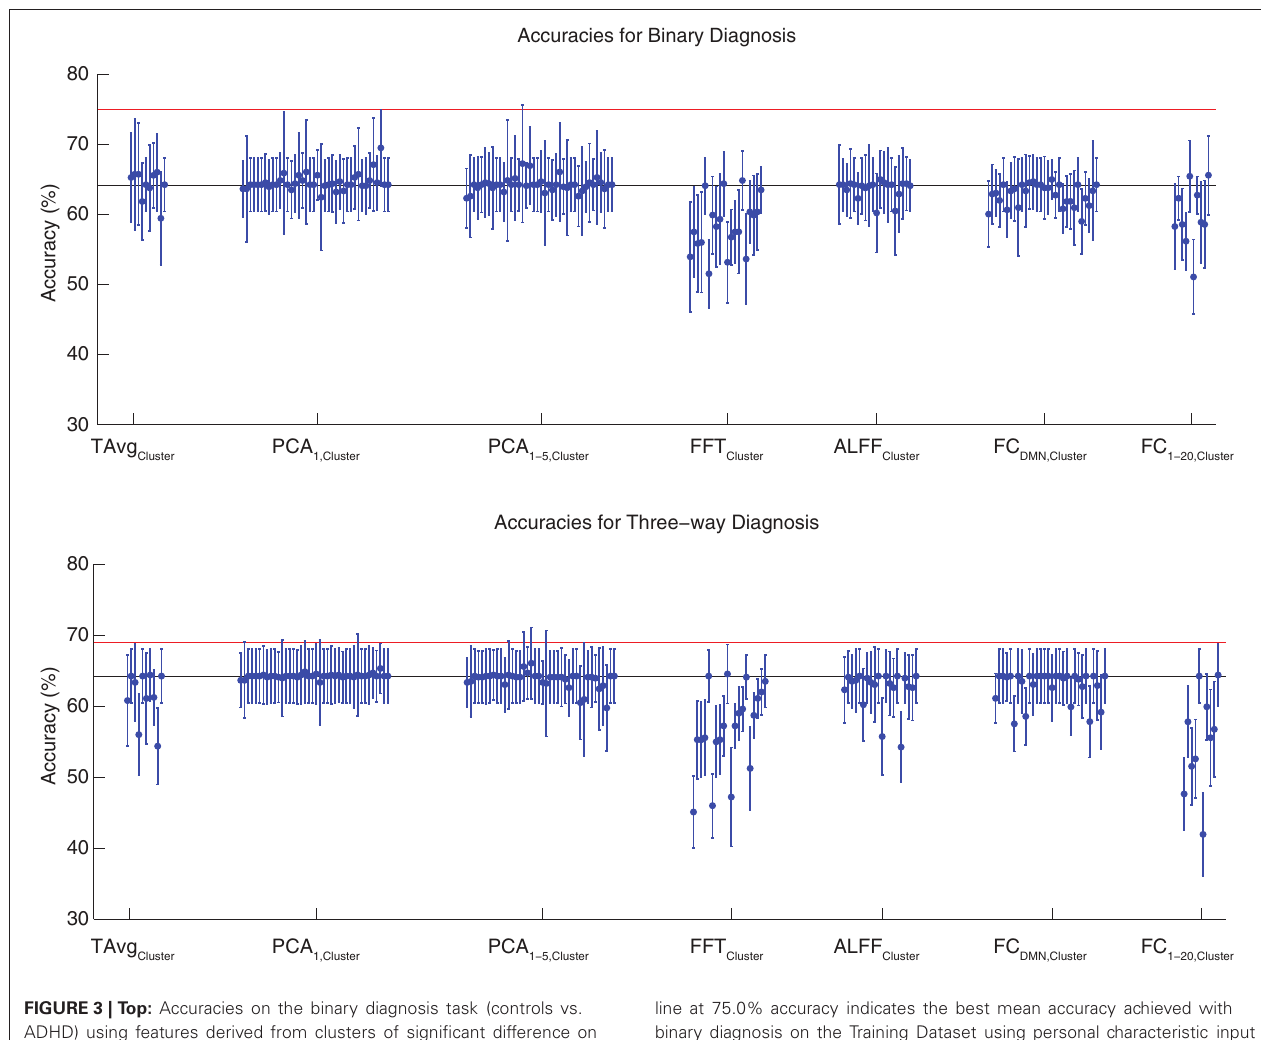
line at 75.0% accuracy indicates the best mean accuracy achieved with binary diagnosis on the Training Dataset using personal characteristic input data (section 3.1). Bottom : Accuracies on the three-way diagnosis task (controls vs. ADHD-C vs. ADHD-I) using same Diagnostic Pipelines as in top panel . The red horizontal line at 69.0% accuracy indicates the best mean accuracy achieved with three-way diagnosis on the Training Dataset using personal characteristic input data (section 3.1). Other conventions as in top panel